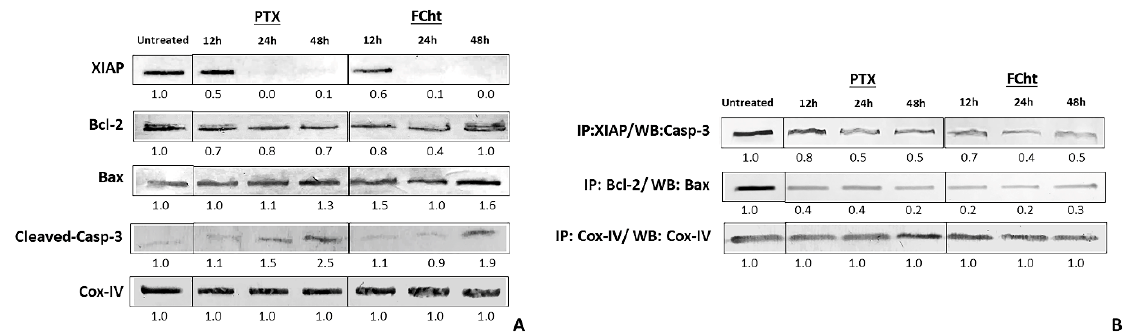
Figure 5. Western blot analysis of antiapoptotic XIAP and Bcl-2 and pro-apoptotic BAX and full- length-Caspase-3proteins and complexes on MDA-MB-231 cells. ( A ) Protein expression levels after treatment with Tacotanina and the positive control PTX for 12, 24, and 48 h. ( B ) Complexes’ levels resulting after treatment with Tacotanina and the positive control PTX for 12, 24, and 48 h. Co-IP the proteins immobilization on Protein G agarose was carried out with anti-XIAP or anti-Bcl-2 and Western blot with anti-Caspase-3 (31A893) and anti-Bax (D2E11), respectively. COX-IV mitochondrial protein was used as the loading control.